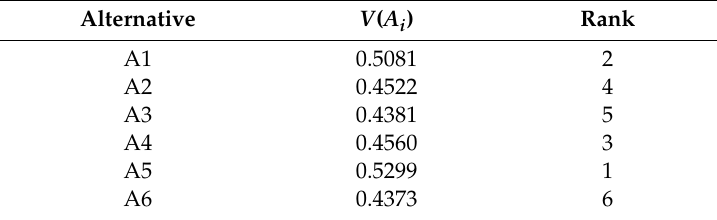
in Table 1. Ranking pre-order of the alternatives is derived as per the descending order of V ( A i ) values, where the alternative with higher V ( A i ) values are always preferred. Table 1. The function criteria and the final ranking of the researchers /